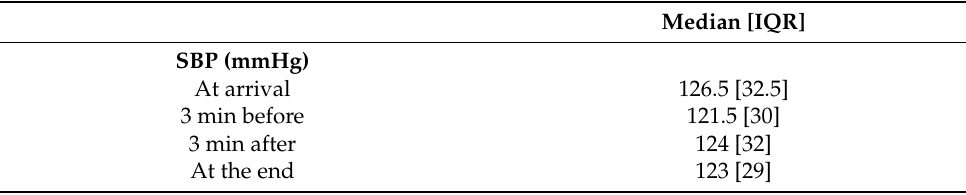
Table 1. Values of SBP, DBP, and HR for all patients ( n =